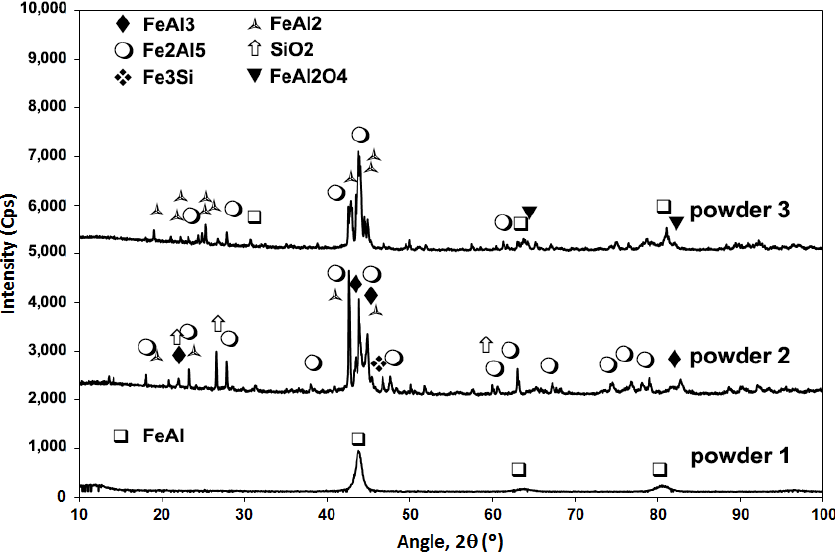
Figure 3. X-ray diffraction of the feedstock powders.